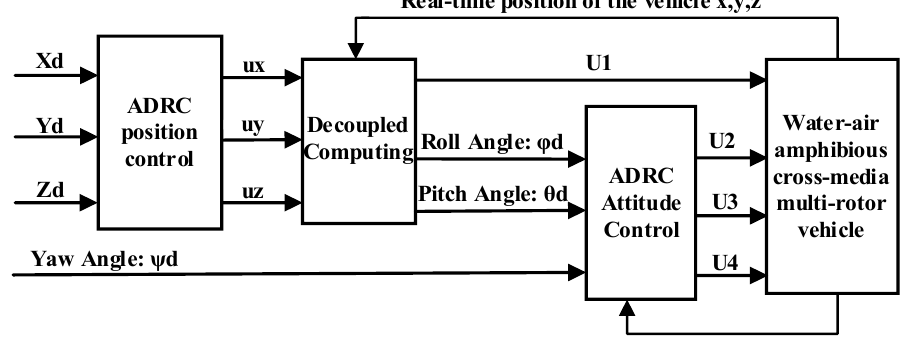
Figure 4. ADRC control block diagram.